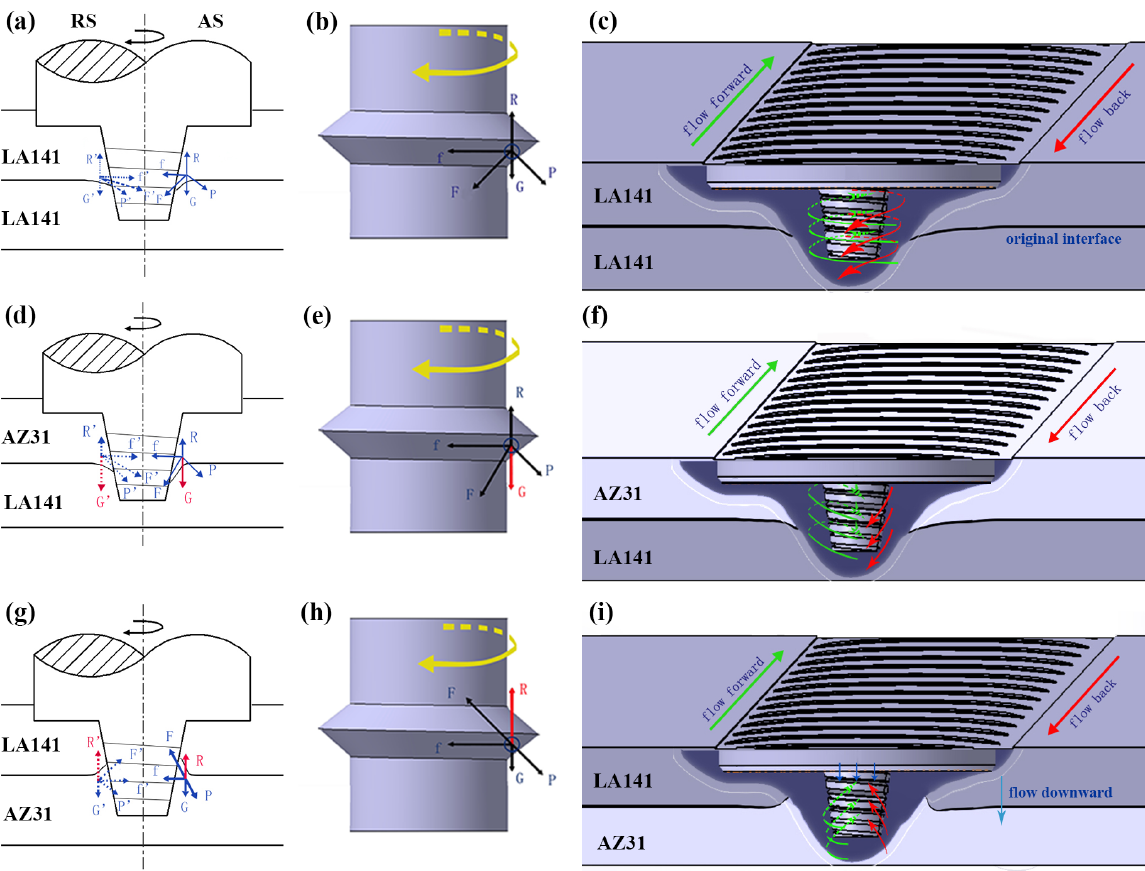
Figure 8: Diagram of (a) the F at the interface, (b) forces on the left thread surface and (c) material flow in the LA141/LA141 lap joint; diagram of (d) the F at the interface, (e) forces on the left thread surface and (f) material flow in the AZ31/LA141 lap joint; diagram of (g) the F at the interface, (h) forces on the left thread surface and (i) material flow in the LA141/AZ31 lap